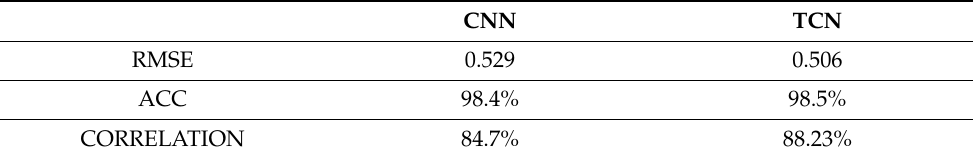
Table 2. Comparison of RMSE and ACC for CNN and TCN models.